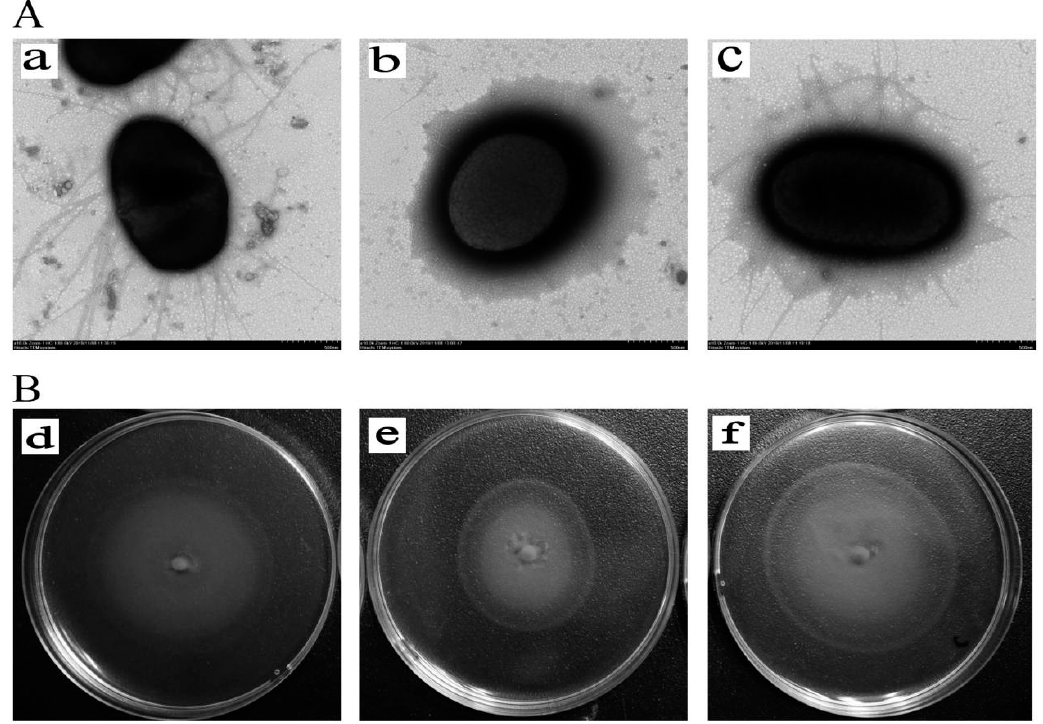
Figure 3. ( A ). The flagella of AE81, AE81 Δ yqeI and AE81 Δ yqeI- pCm yqeI in the transmission electron micrographs views ( × 10,000). ( a ) The morphological observation of AE81 ( × 10,000); ( b ) the morphological observation of AE81 ∆ yqeI ( × 10,000); ( c ) the morphological observation of AE81 ∆ yqeI -pCm yqeI ( × 10,000) ( B ). The observation of motility ability. ( d ) The motility circle of the wild strain AE81; ( e ) the motility circle of AE81 ∆ yqeI ; ( f ) the motility circle of AE81 ∆ yqeI -pCm yqeI .